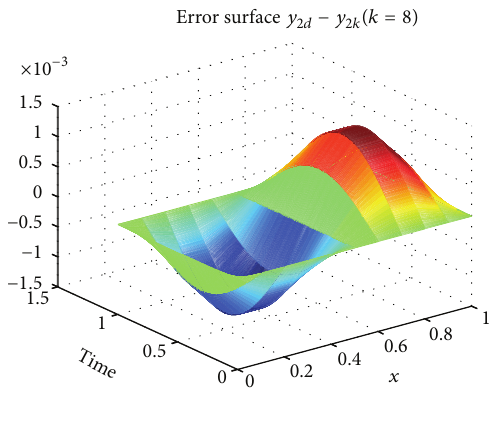
Figure 3: 8th iteration output 1.